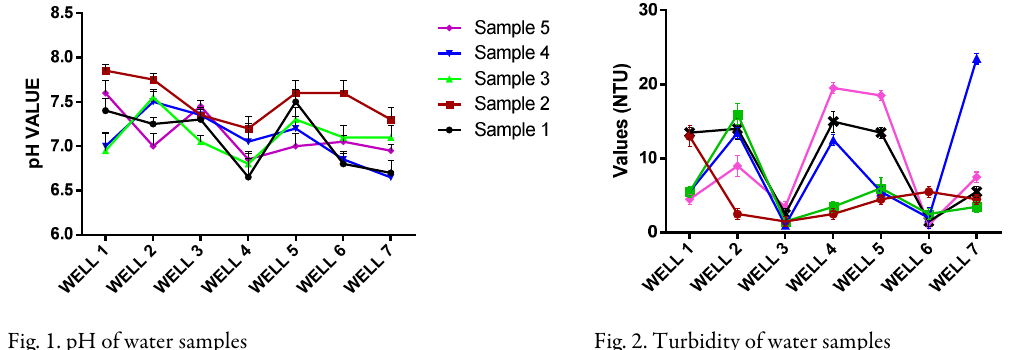
Fig. 1. pH of water samples Fig. 2. Turbidity of water samples